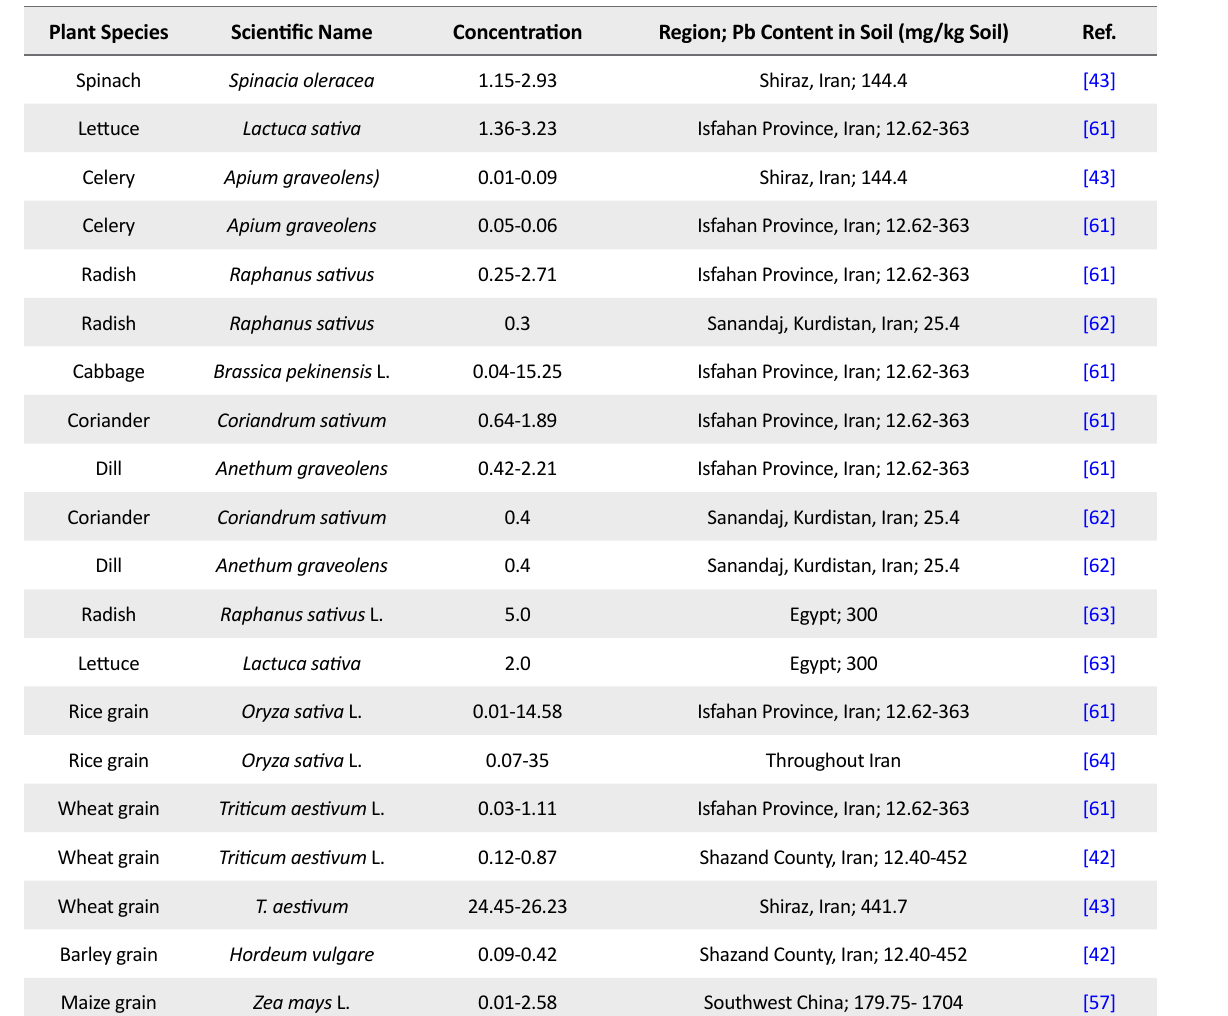
Table 2. Based on the obtained data, the concentration range of Pb in agricultural soils of Iran was from 2.4 (Khuzestan